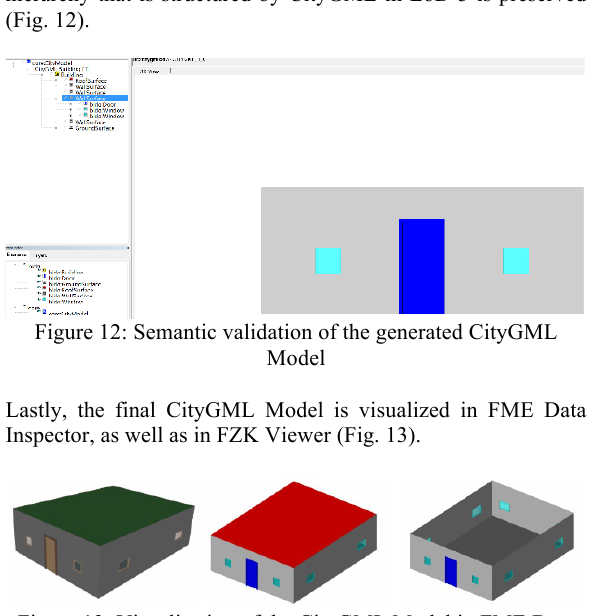
Figure 13: Visualisation of the CityGML Model in FME Data Inspector and in FZK Viewer, with and without